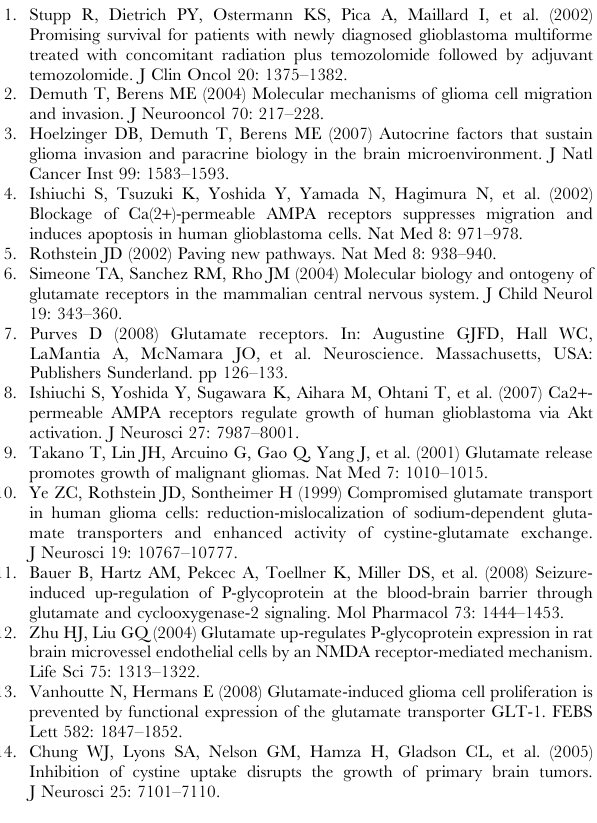
Table S1 In silico analysis using Oncomine [18], comparing mRNA expression profiles in dataset of 77 GBMs with 23 samples of non-neoplastic control brain tissue [19]. The t-test value indicating effect size between the two classes, p-value reflecting significance of the differential expression